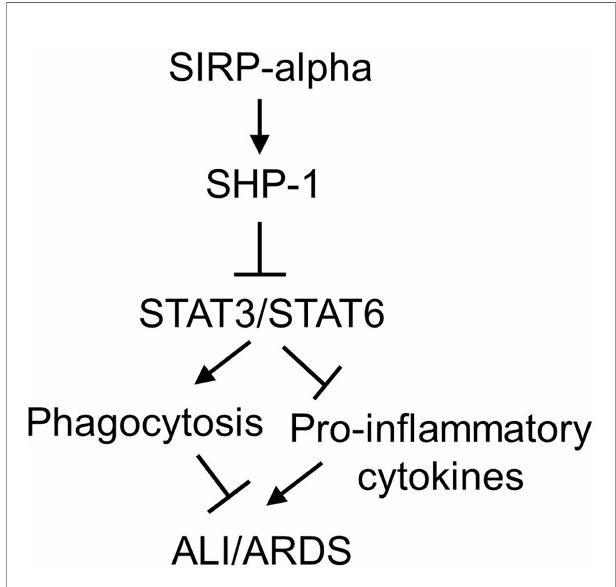
FIGURE 9 | Schematic diagram of SIRP-alpha downstream signaling pathways in modulation of macrophages and development of ALI/ARDS. In LPS-induced ALI, the expression and release of soluble SIRP-alpha are increased, subsequently activates SHP-1, and suppresses activation of STAT3 and STAT6. Activation of STAT3 and STAT6 promotes macrophage phagocytosis, clearance of apoptotic and dead cells in the in fl amed lung tissues, subsequently improving in fl ammation resolution and tissues repair in